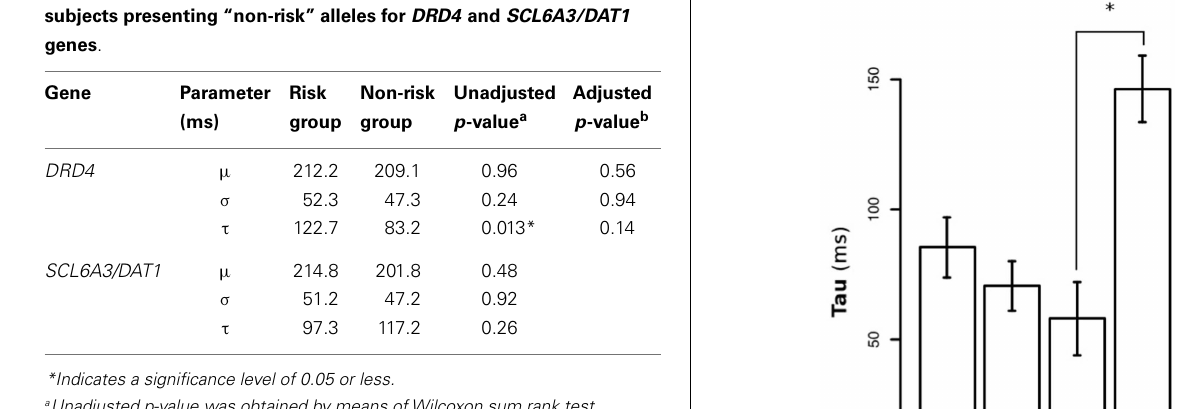
Table 3 | Estimated effects for all co-variates included in the linear regression models adjusted for µ , σ , and τ . Model for ...